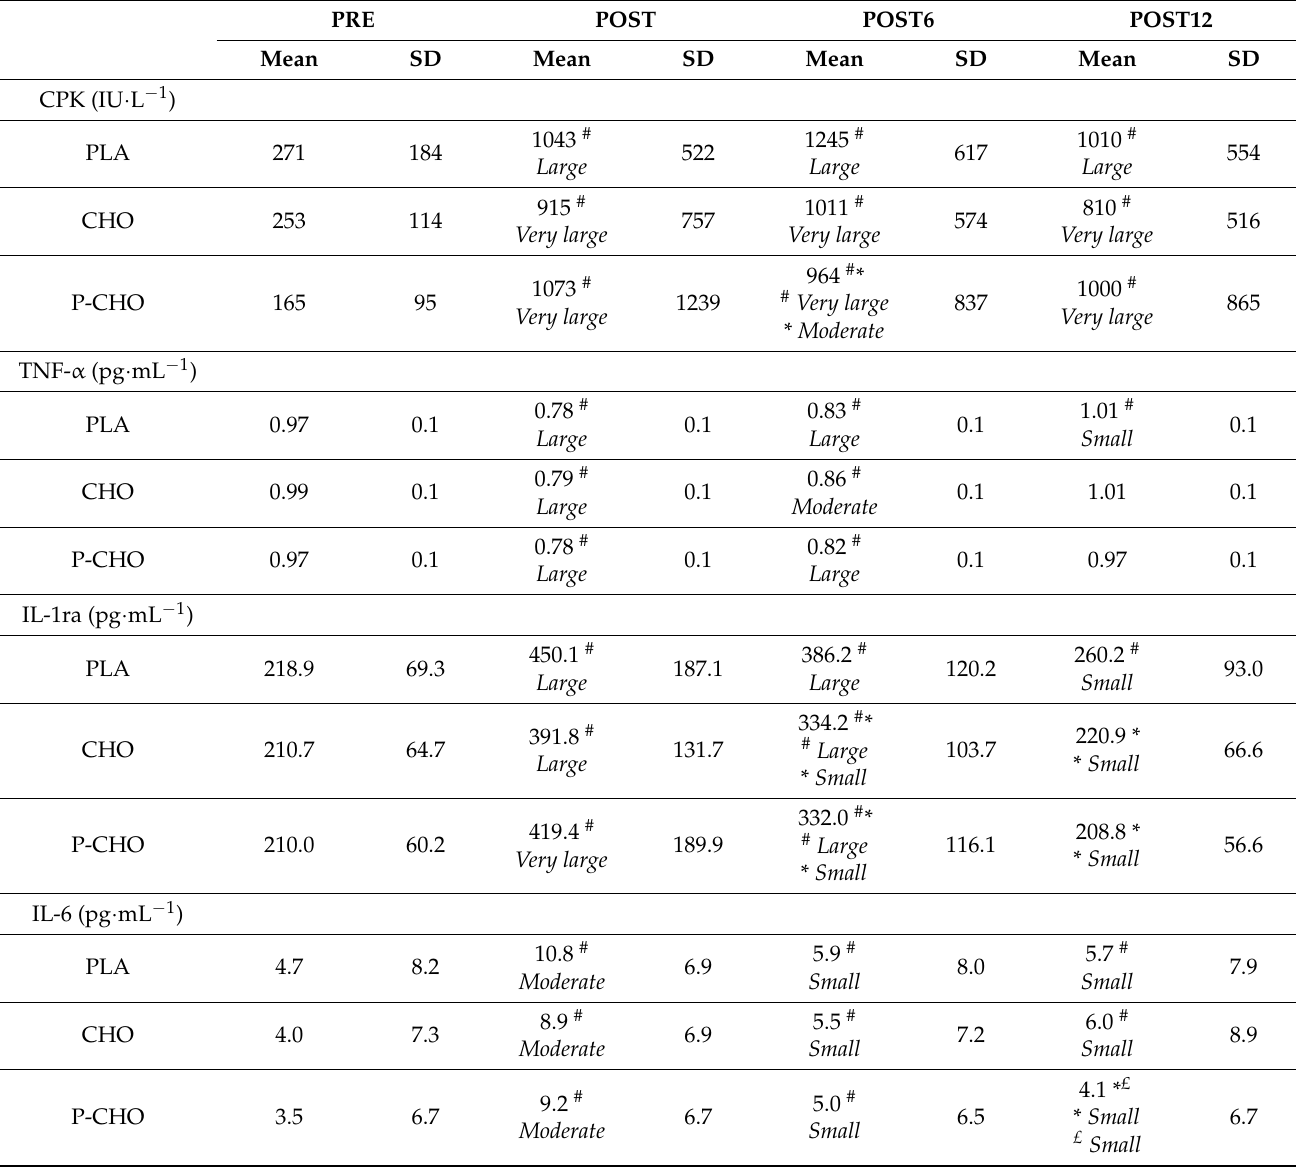
Table 2. Markers of muscle damage and